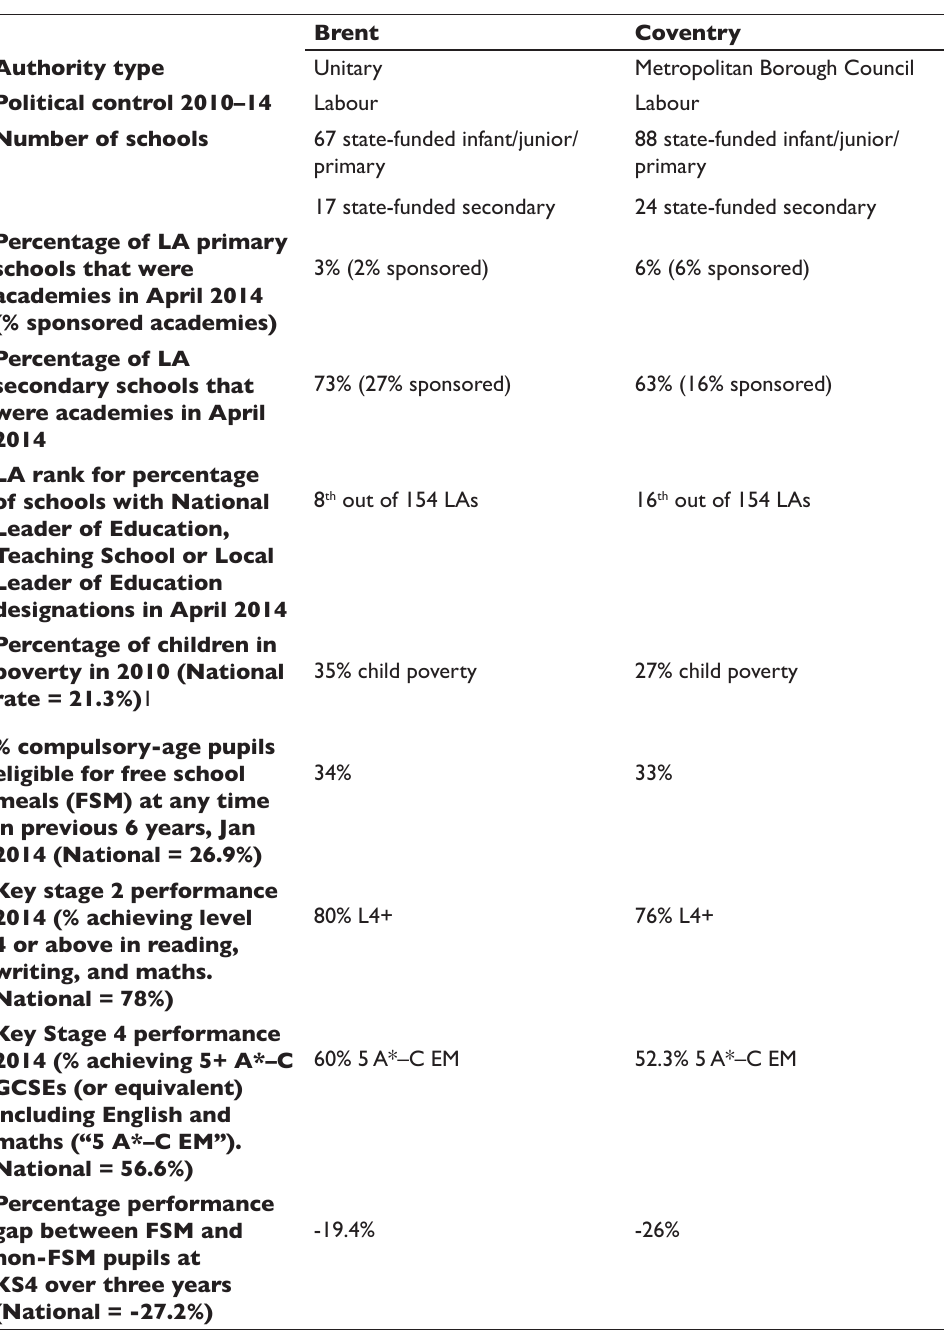
Table 1: Brent and Coventry Local Authorities: Key